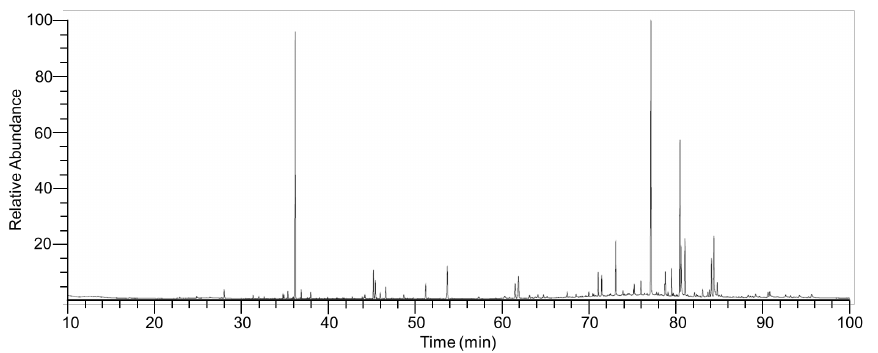
Figure 7. GC/MS total ion chromatogram of Caragana sinica flower absolute showing the peaks of the 46 identified compounds listed in Table 1.